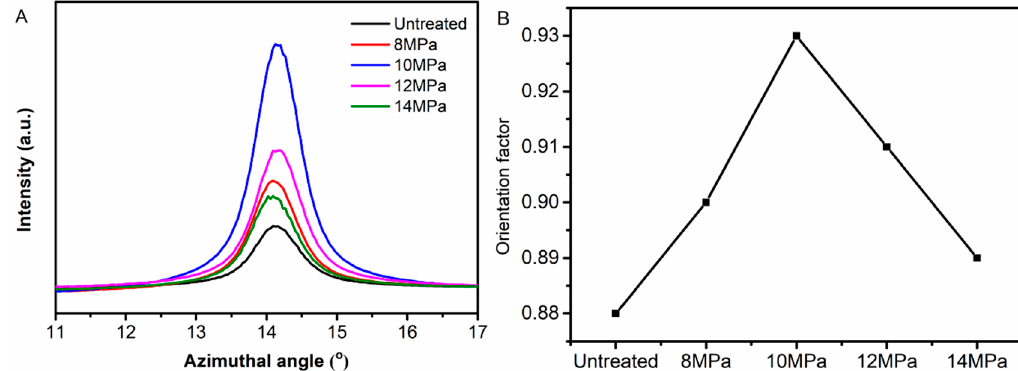
Figure 5. ( A ) Azimuthal scan curves of the (100) plane and ( B ) Orientation factor of (100) plane of PAN fibers treated at different pressures.